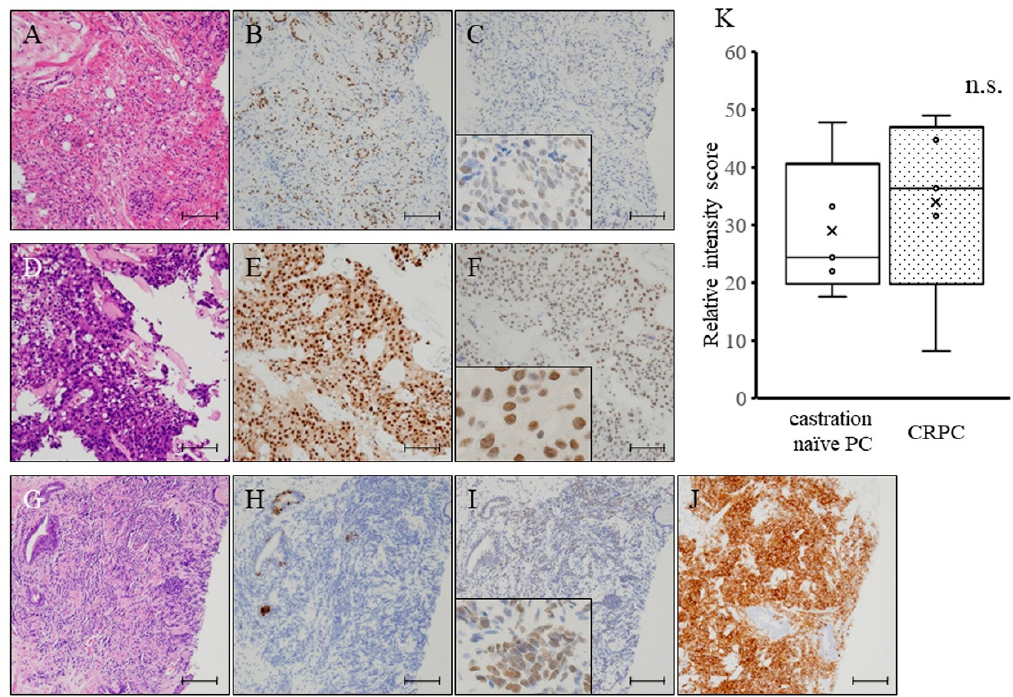
Figure 1. ( A – F ) Hematoxylin and eosin (HE) staining ( A ), and immunohistochemistry for Nkx3.1, a sensitive specific marker of differentiated adenocarcinoma originating from the prostate ( B ), and histone lysine demethylase 1 (LSD1) ( C ) of castration-naïve prostate cancer (castration-naïve PC) specimens obtained by prostate biopsy for an initial diagnosis in patients. HE staining ( D ), and immunohistochemistry for Nkx3.1 ( E ), and LSD1 ( F ) of castration-resistant prostate cancer (CRPC) specimens obtained by prostate biopsy after the acquisition of castration resistance and treatment with androgen deprivation therapy. Nuclei were counterstained with hematoxylin. Scale bar is 50 µ